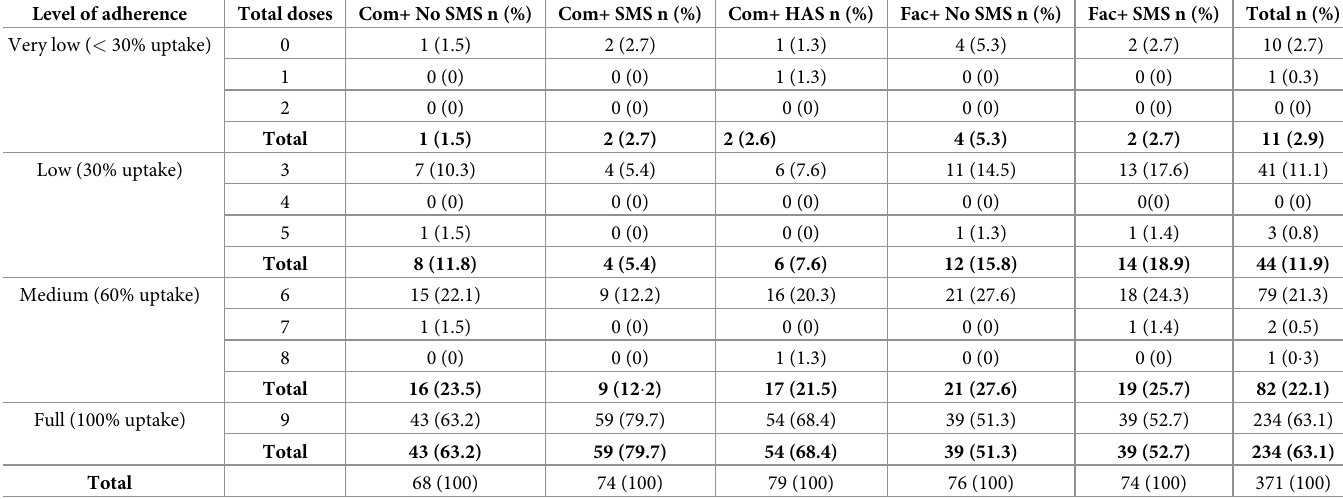
Overall, a total of 83.6%, 84.1% and 78.0% of the children received complete courses of PMC1, PMC2 and PMC3 respectively. Generally, most of the children who received the first dose of each PMC course also received the second and the third dose. A small proportion (1.3%) received the first and second dose but not the third dose of PMC 1, only one participant (0 � 3%) took only the first dose of PMC 2 and another one (0.3%) took only the first and second doses of PMC 2. All participants who took the first course of PMC 3 completed all the three doses. Table 3. Levels of adherence to DHP across all the trial